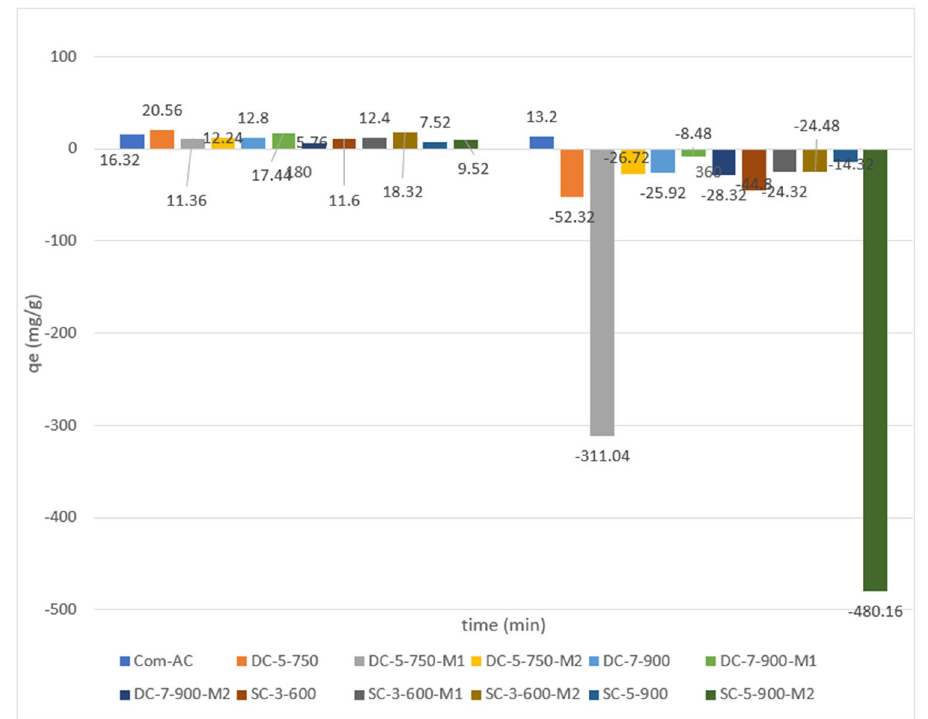
Figure 14. preliminary adsorption capacity for